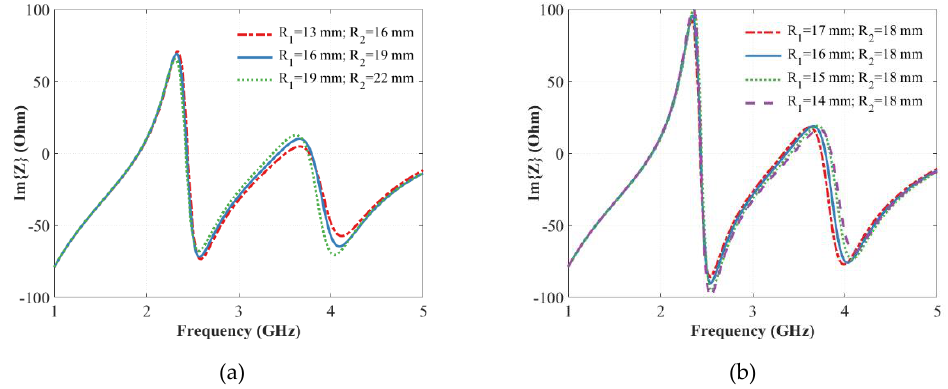
Figure 5. Imaginary part of the input impedance as a function of frequency in case the width and the height of the empty ring are fixed ( a ), and by varying the width of the empty ring for a fixed R 2 ( b ).